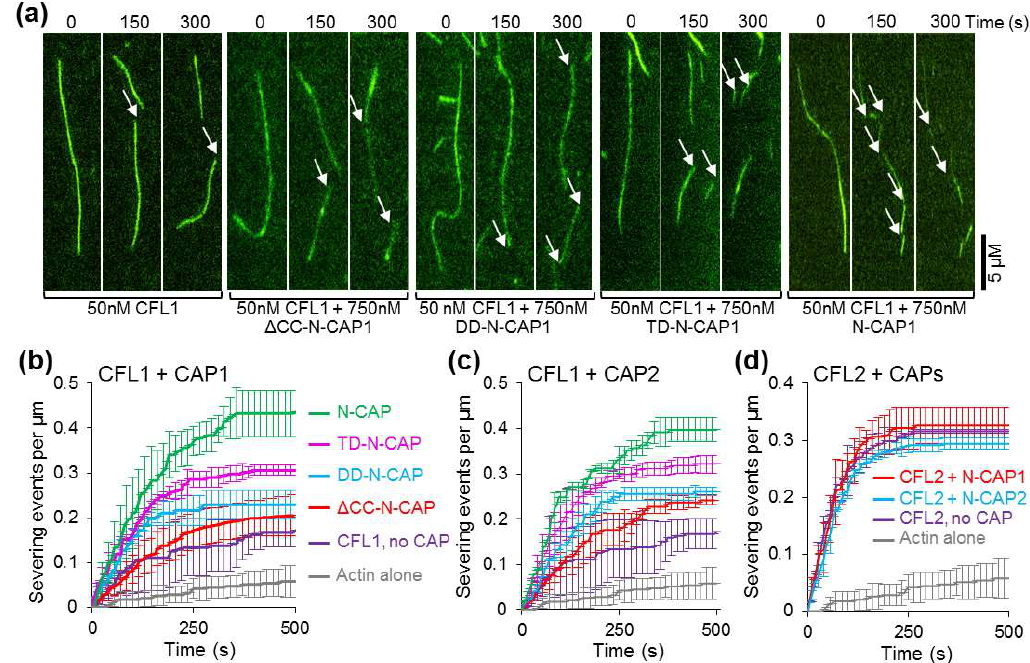
Figure 6. Effects of N-CAP constructs on cofilin-mediated F-actin severing observed by total internal reflection fluorescence (TIRF) microscopy. ( a ) Representative time-lapse images of Alexa 488-labeled F-actin severing upon addition of CFL1 in the absence or presence of N-CAP1 constructs. Arrows indicate severing events. ( b – d ) Analysis of severing activities: each data point represents the mean value of the number of severing events per micron of filament from three independent experiments (10–15 filaments per experiment). For clarity, error bars representing standard deviations of the mean are shown for every third data point.